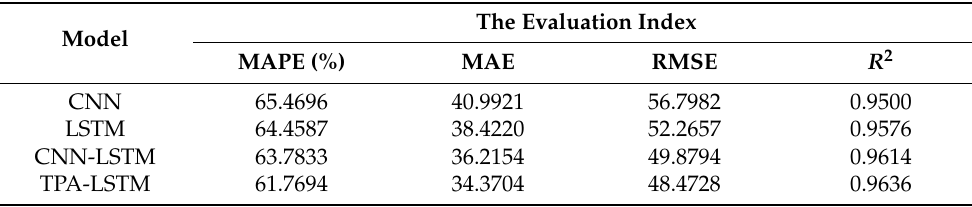
Table 6. Error analysis of prediction results of various models at Jinjiang Station.